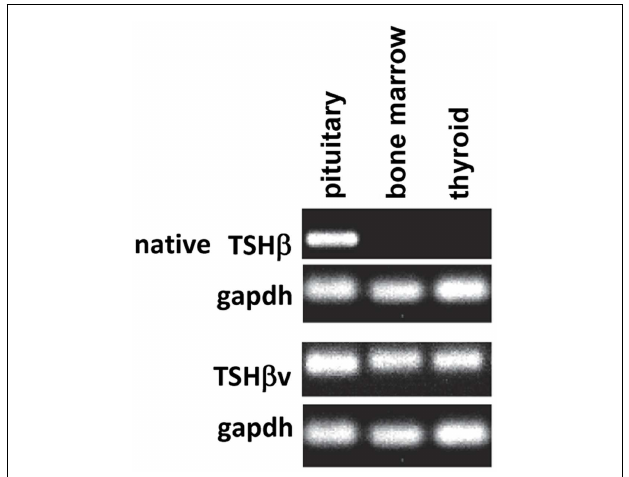
FIGURE 1 | PCR analysis of nativeTSH β andTSH β v gene expression in mouse pituitary, bone marrow, and thyroid tissues . Note the expression of the native form ofTSH β in the pituitary but not the bone marrow and thyroid, and the expression of theTSH β in all three tissues. Presented data were derived from Ref. (10).